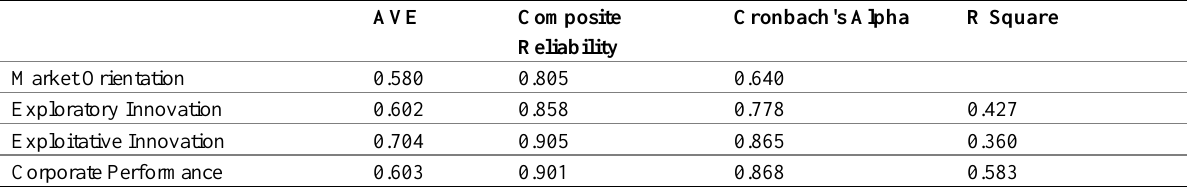
Table 2: Validity and Reliability